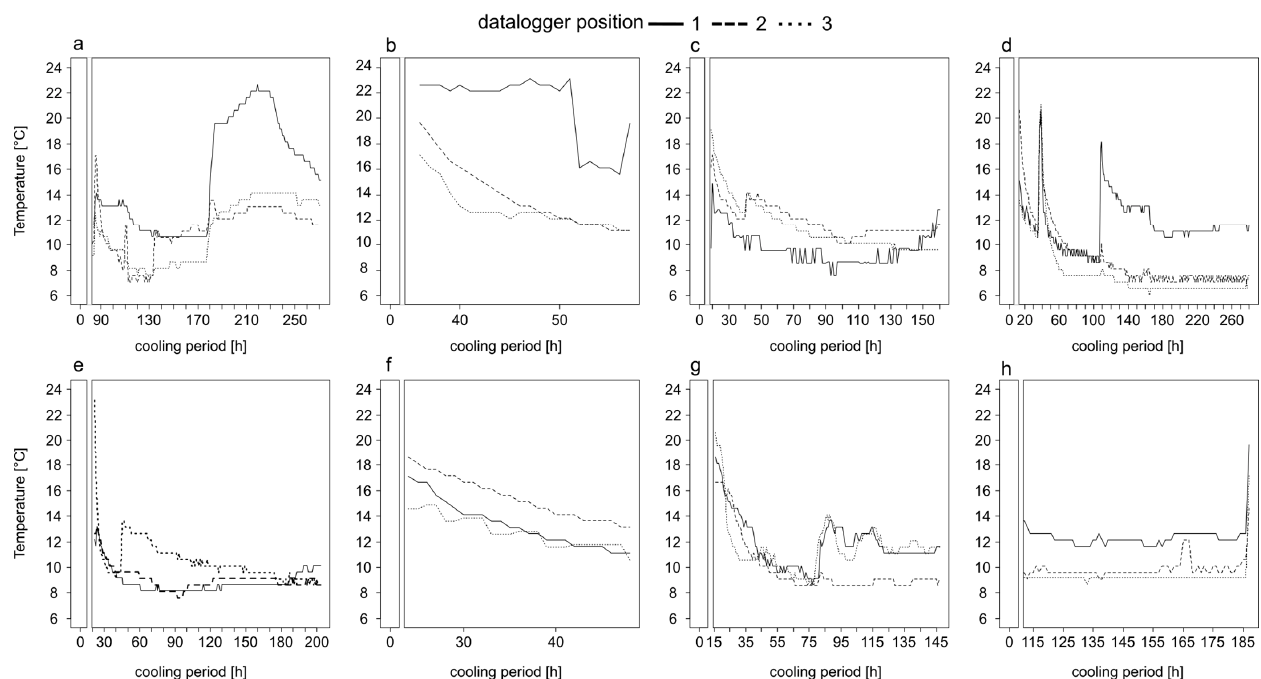
Figure 1. Temperature profiles of bodies heavily infested with insect larvae stored in a walk-in cooler in the Institute of Legal Medicine Frankfurt from May until August 2017. Information on the exact position of the iButton on the body, the period of temperature measurement and the entire cooling period are given in Table 1. The temperature profiles belong to corpse 1 ( a ), corpse 2 ( b ), corpse 3 ( c ), corpse 4 ( d ), corpse 5 ( e ), corpse 6 ( f ), corpse 7 ( g ) and corpse 8 ( h ).